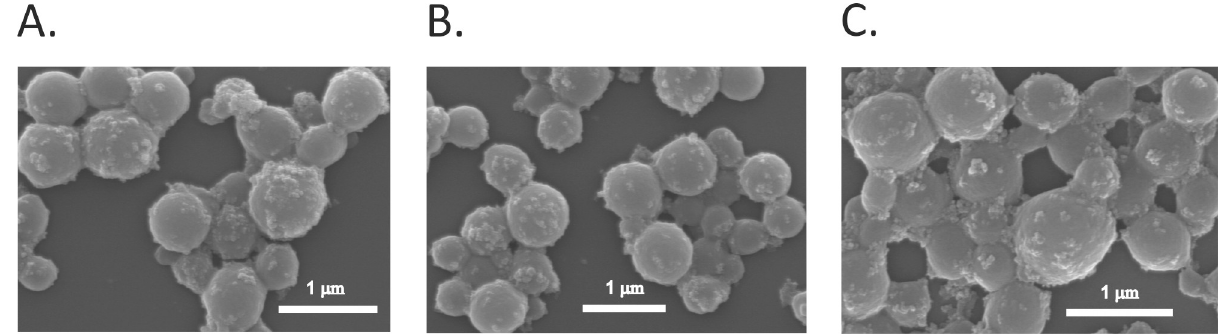
Fig 7. The SEM images of A) EMS2/IONP spheres B) EMS2/IONP spheres loaded with doxorubicin and C) EMS2/IONP spheres after the release of doxorubicin. EMS2/IONP spheres were prepared by mixing 2 M potassium phosphate at pH 8 with silk (1 mg/mL) and iron oxide nanoparticles (5 mg/mL) and then were loaded with Dox by the post-loading method. Next, Dox was released from EMS2/IONP spheres for 7 days at pH of 4.5; scale bar– 1 μ m.